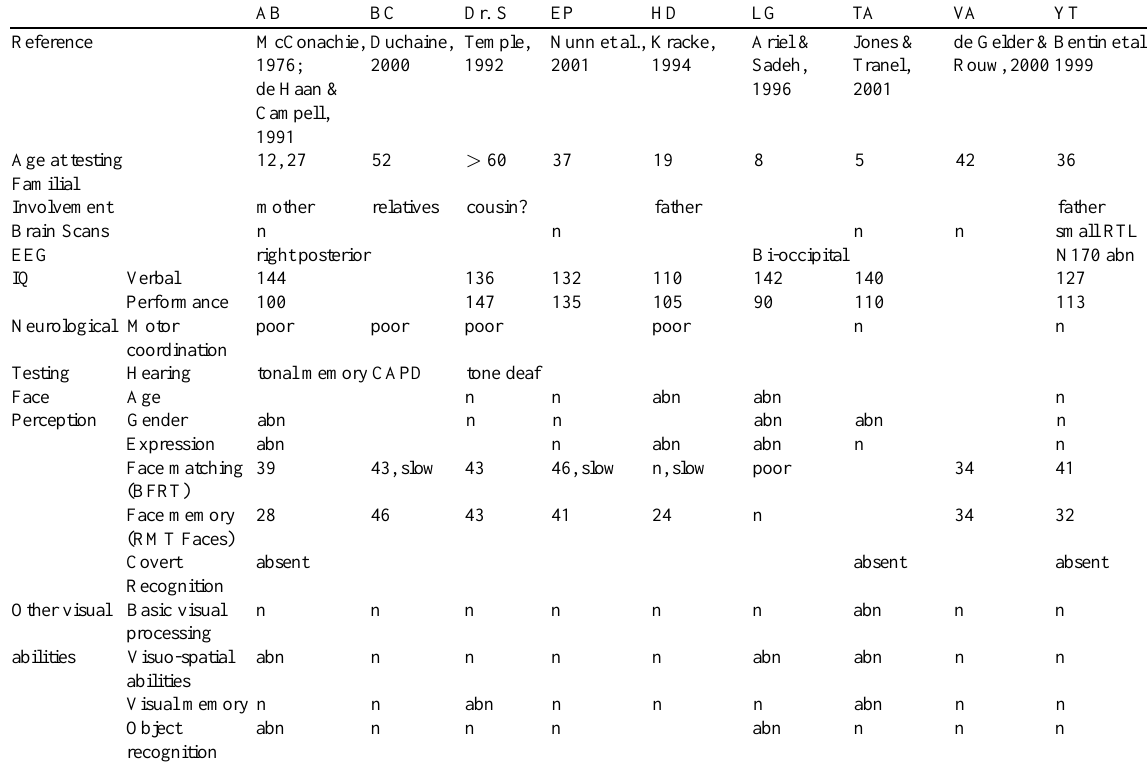
Table 1 Summary of patients with developmental